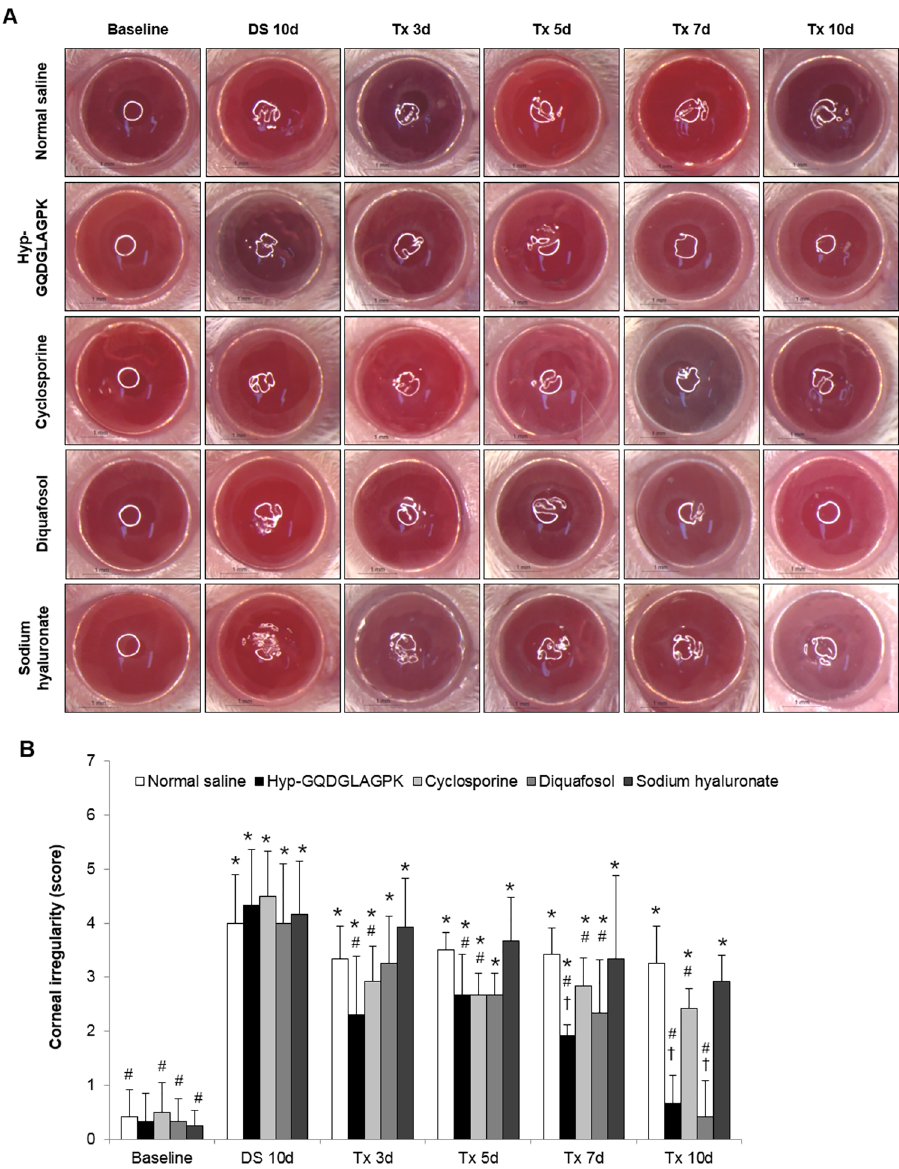
Figure 2. Effects of Hyp-GQDGLAGPK on corneal surface irregularities in the experimental dry eye mouse model. ( A ) Images of the eyes of the Hyp-GQDGLAGPK, cyclosporine, diquafosol, and sodium hyaluronate groups were photographed with a microscope at baseline; after DS 10d; and after treatment for 3, 5, 7, and 10 days. Scale bar = 1 mm. ( B ) The changes in the corneal irregularity scores was measured in the Hyp- GQDGLAGPK, cyclosporine, diquafosol and sodium hyaluronate groups. The quantitative data are presented as means ± SD (n = 13). The results are statistically significant by analysis of variance with the Tukey test at * p < 0.05 compared with baseline, # p < 0.05 compared with DS 10d and † p < 0.05 vs corresponding value in the normal saline group. Baseline = before desiccation stress; DS 10d = immediately after desiccation stress for 10 days; Tx 3d, Tx 5d, Tx 7d, and Tx 10d = 3, 5, 7 and 10 days after treatment with Hyp-GQDGLAGPK, cyclosporine, diquafosol, and sodium hyaluronate eye drops,